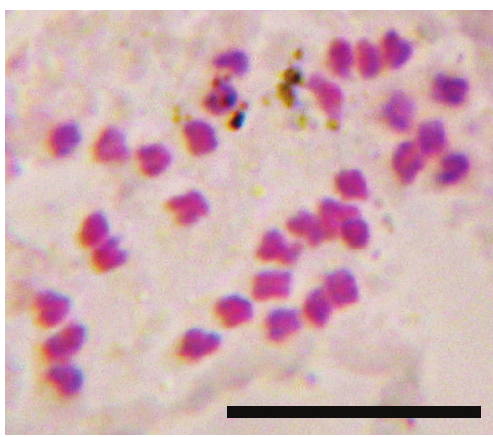
Figure 4. Teucrium flavum L. subsp. flavum , 2 n = 32. Scale bar: 10